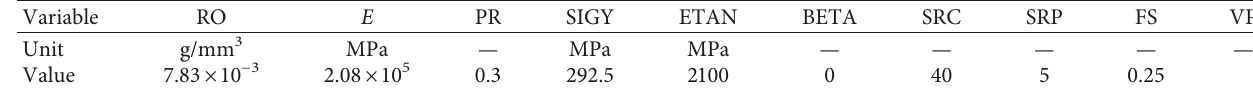
Table 3: Variables of the steel material